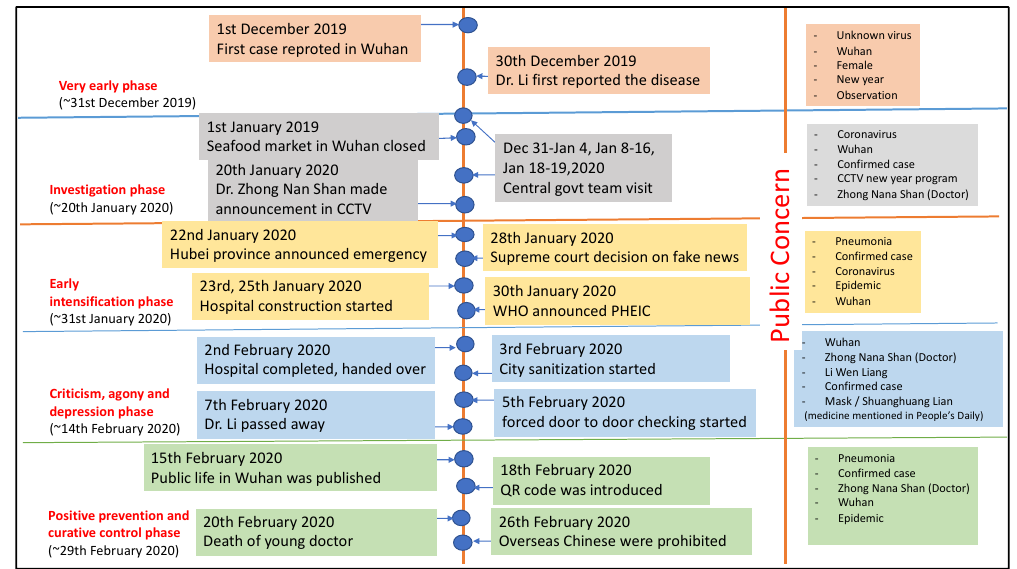
Figure 2. Timeline of key events and public concern; (Source: This figure was prepared by the authors using original data from: Sina, Tiki-Toki, Caixin, Baidu: [6-21]).